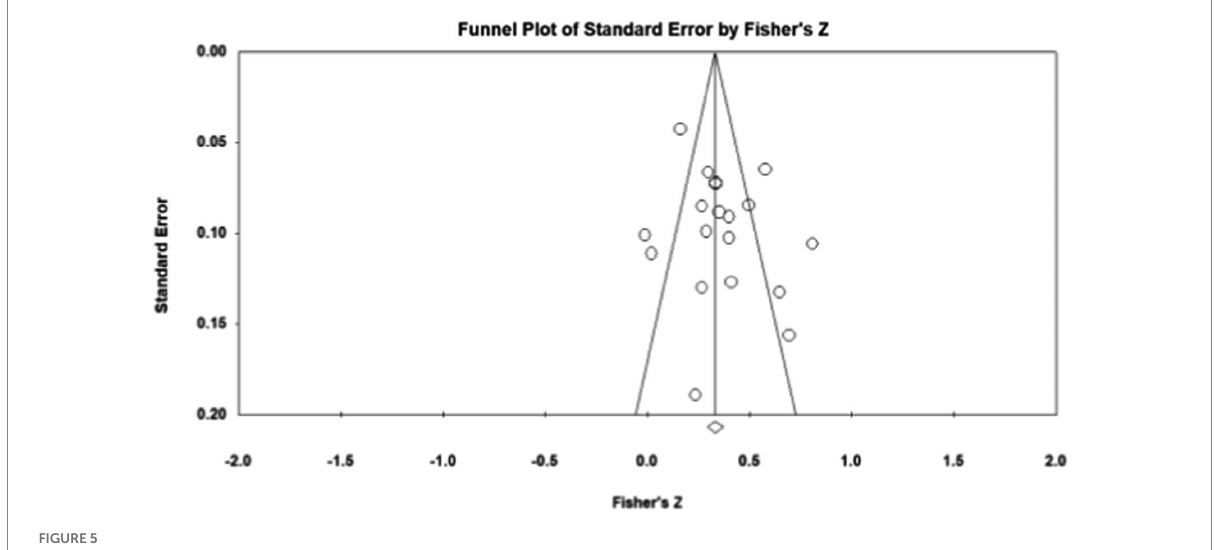
FIGURE 5 Funnel plot. Cognitive flexibility—Mathematics.